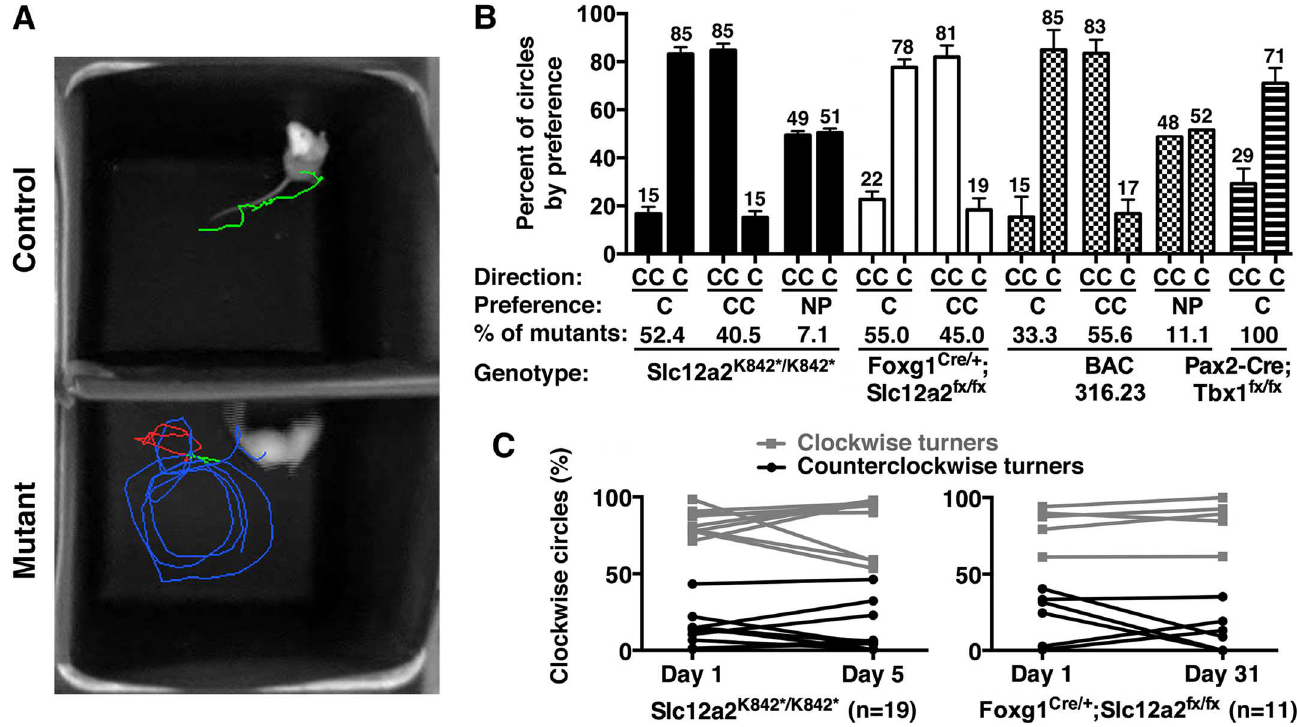
Fig 1. Asymmetric motor behavior in mice is associated with inner ear dysfunction. (A) Thirty-second trace of an Slc12a2 K842 (cid:3) /K842 (cid:3) and control mouse. Turns: blue, CC; red, C; green, none. (B) The majority of mutant mice have a bias in the C or CC direction. Slc12a2 K842 (cid:3) /K842 (cid:3) , C: n = 22; CC: n = 17; NP: n = 3. Foxg1 Cre/+ ; Slc12a2 fx/fx , C: n = 11; CC: n = 10. BAC 316.23, C: n = 3; CC: n = 5; NP: n = 1. Pax2-Cre;Tbx1 fx/fx , C: n = 4; mean ± SEM. See also S1 Data. (C) The directional preference is stable over time. Mean percent of clockwise circles: Slc12a2 K842 (cid:3) /K842 (cid:3) C turners, day 1 versus 5, p > 0.9999; CC turners, day 1 versus 5, p > 0.9999; Foxg1 Cre/+ ; Slc12a2 fx/fx C turners, day 1 versus 31, p > 0.9999; CC turners, day 1 versus 31, p = 0.42. Mean ± SEM, repeated measures ANOVA with Bonferroni multiple comparison test. See also S1 Data. BAC, bacterial artificial chromosome; C, clockwise; CC, counterclockwise; NP, no preference; SEM, standard error of the